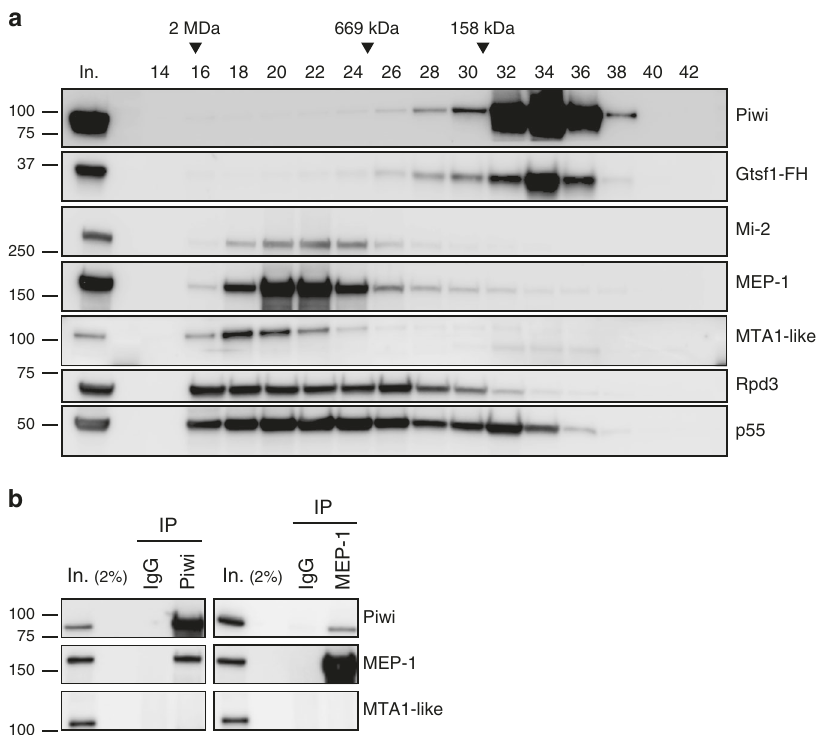
Fig. 2 Rdp3, Mi-2, and MEP-1 are not associated with Piwi and Gtsf1 as a stable preformed subunit. a Superose 6 gel fi ltration of nuclear extracts from OSCs. Fractions were analyzed by western blotting using the indicated antibodies. Fraction numbers and molecular mass standards are indicated on the top. Input (In.): 2% of extract loaded onto the column. b Western blot analysis of co-IP of endogenous Piwi and MEP-1 from OSC nuclear extract. Mouse and rabbit IgGs were used as control IPs for Piwi and MEP-1, respectively. The amount of inputs loaded relatively to IPs is 2%. Source data: uncropped blot images are provided in Supplementary Data set